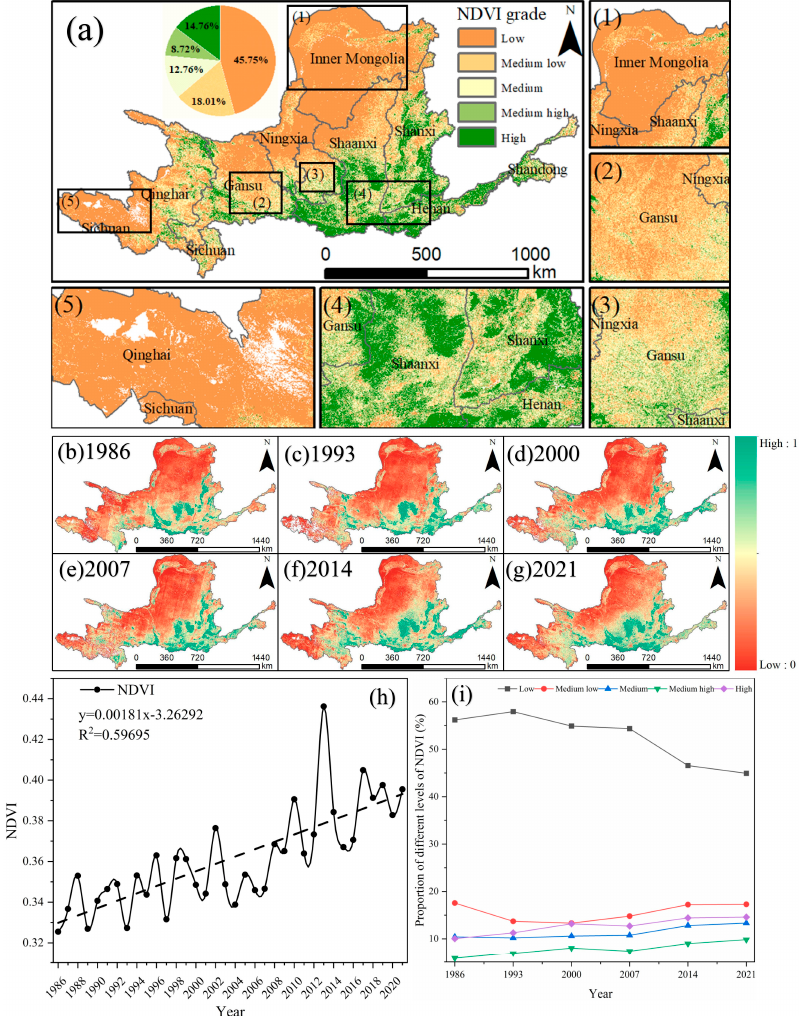
Figure 2. ( a ): spatial distribution of vegetation in different grades, ( b – g ): spatial distribution of NDVI from 1986 to 2021, ( h ): temporal variation of NDVI , ( i ): Interannual variation of NDVI at different